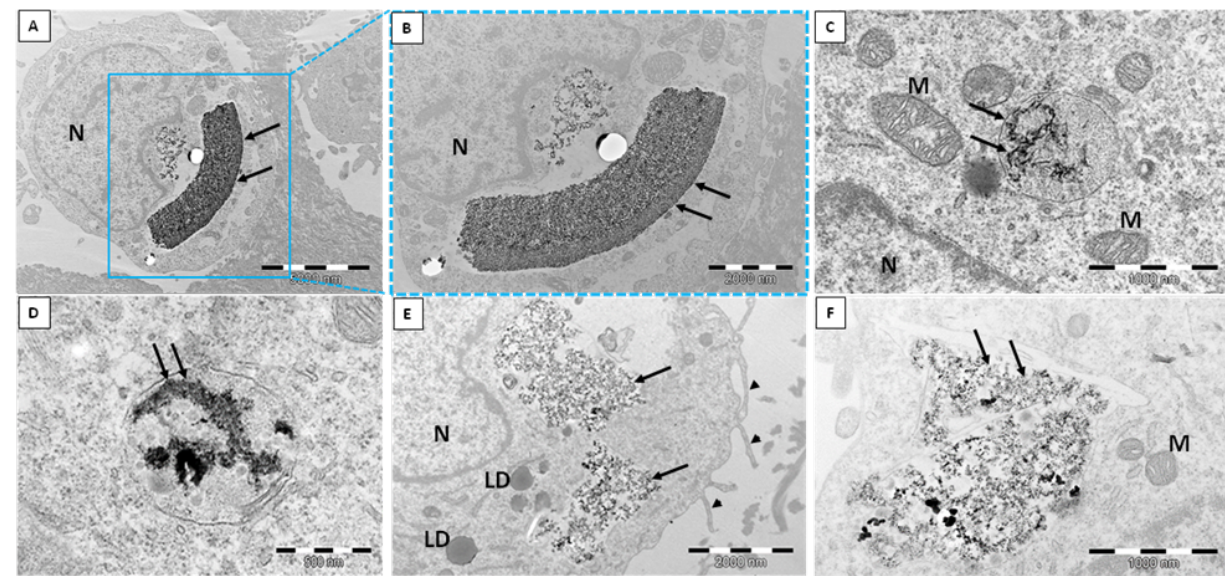
Figure 1. Internalization of silica nanoparticles into the HMEC-1 cell line. Large and electron-dense aggregates of bio SiO 2 ( A , B ) and more dispersed nanoparticles of pyr SiO 2 ( E , F ) in the cytoplasm or inside the vesicles. Arrows—SiO 2 nanoparticles; N—nucleus; M—mitochondria with lamellar cristae; LD—lipid droplets; arrowheads—cell membrane cytoplasmic extensions. ( A – D )— bio SiO 2 ; ( E , F )— pyr SiO 2 .